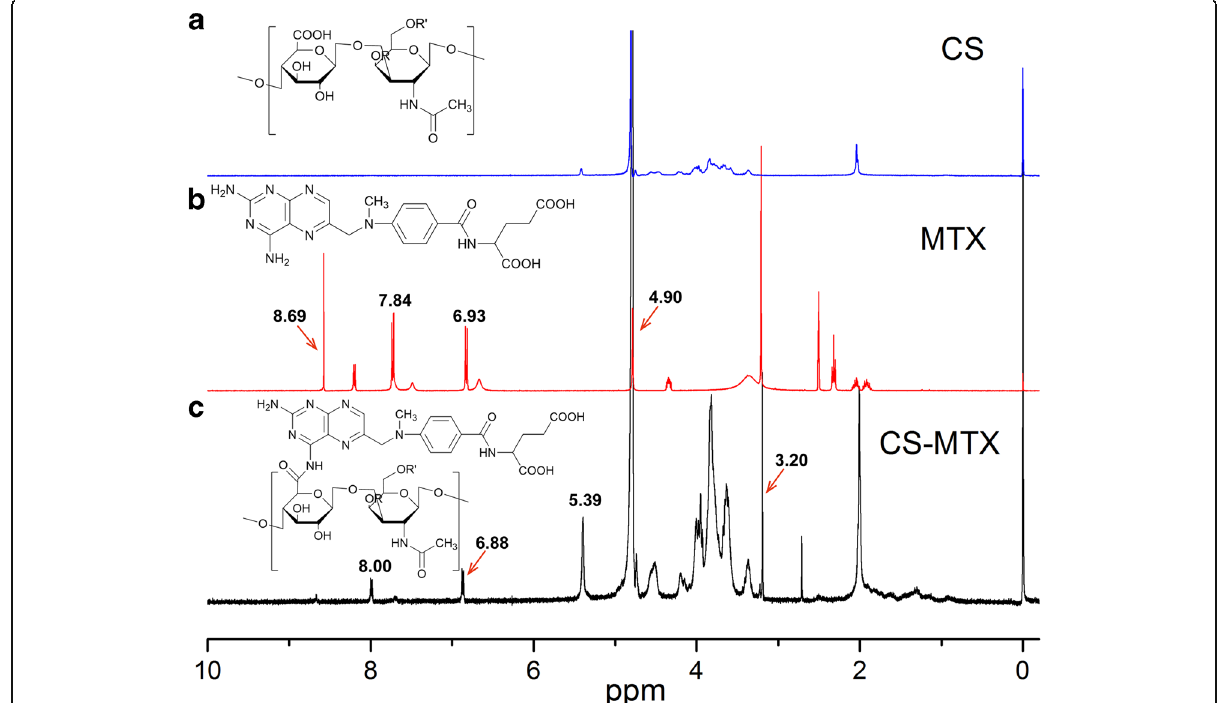
Fig. 2 1 H NMR spectra of CS, MTX, and CS-MTX. a 1 H NMR spectra of CS; CS was dissolved in D 2 O. b 1 H NMR spectrum of MTX; MTX was dissolved in